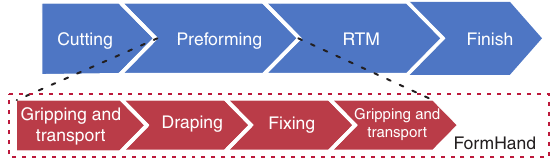
Figure 1 Process chain of a RTM production process and integra- tion of FormHand.